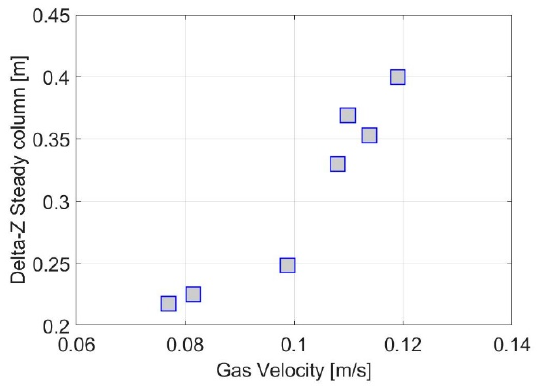
Figure 5. Bubble reactor prototype experimental results.